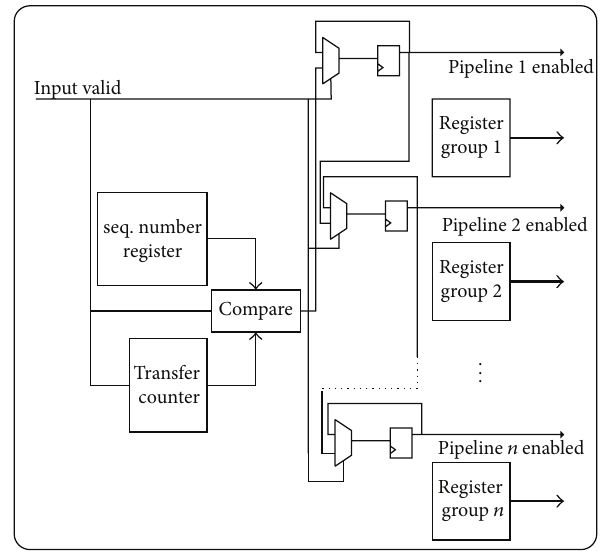
Figure 4: Partial diagram of controller module.